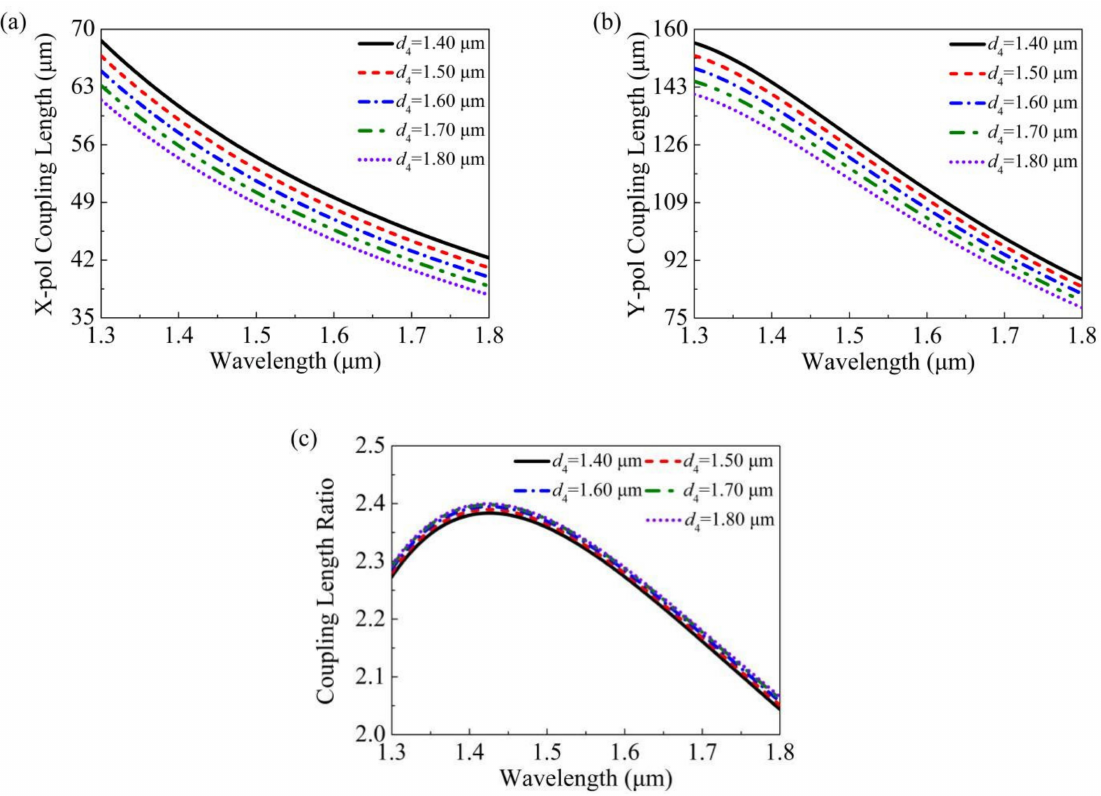
Figure 9. The change rules of the ( a ) CL X , ( b ) CL Y , and ( c ) CLR of the LC-DC-PCF with wavelengths for different d 4 .